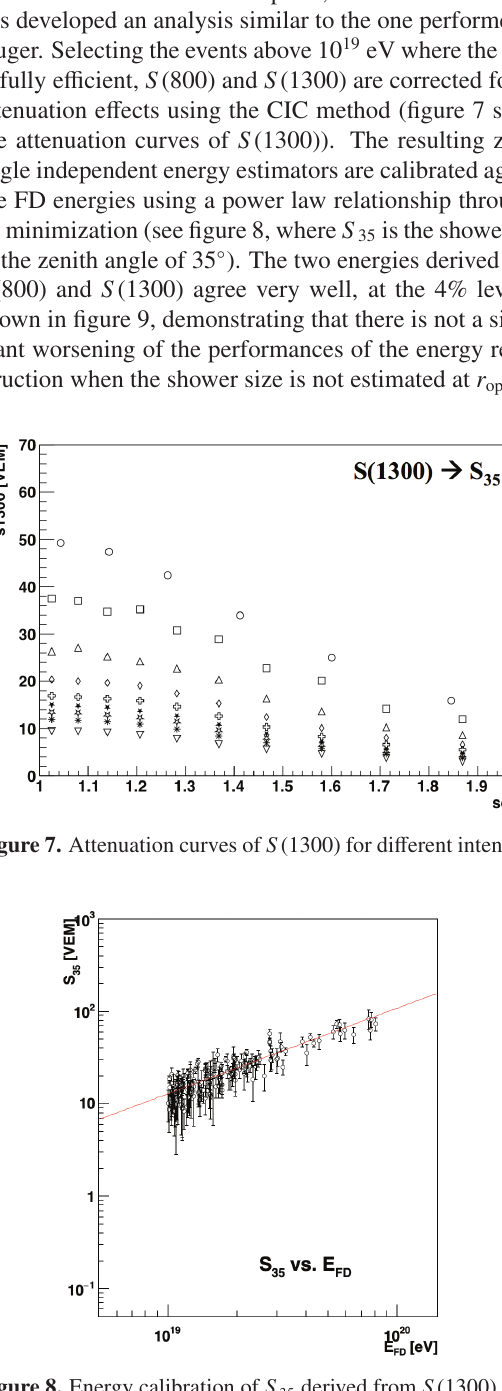
Figure 8. Energy calibration of S 35 derived from S (1300).